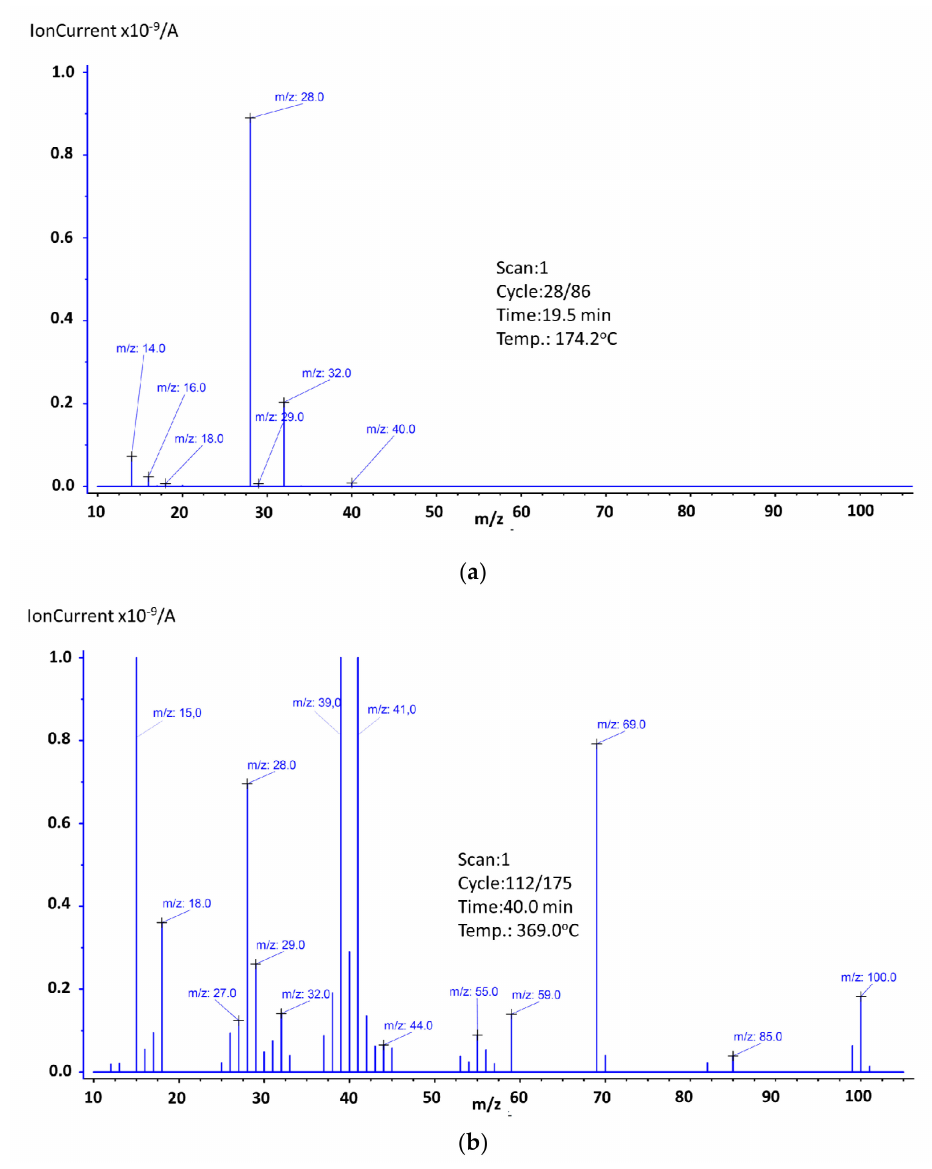
Figure 9. Mass spectra of Tb:2,6-DClB/PMMA at endothermic maxima: ( a ) 174.2 ◦ C; ( b ) 368.8 ◦ C. Some shifts compared to the DSC temperature value shown in Table 3 were observed because of the apparatus response